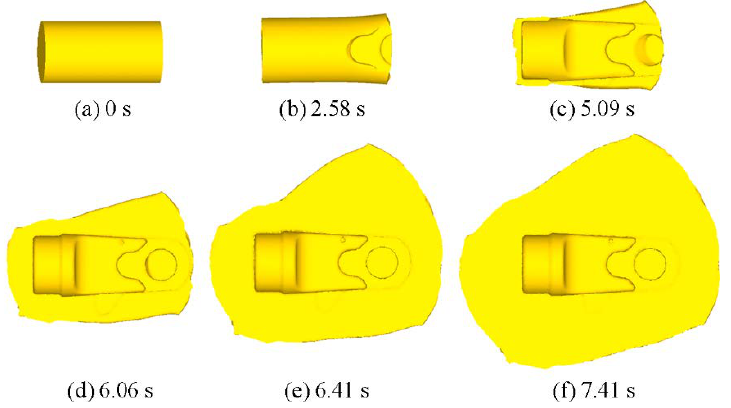
Figure 10. Forming shape evolution of bottom part of component with length of 58 mm under different forming time during cold orbital forming: ( a ) t = 0 s; ( b ) t = 2.58 s; ( c ) t = 5.09 s; ( d ) t = 6.06 s; ( e ) t = 6.41 s; ( f ) t = 7.41 s.